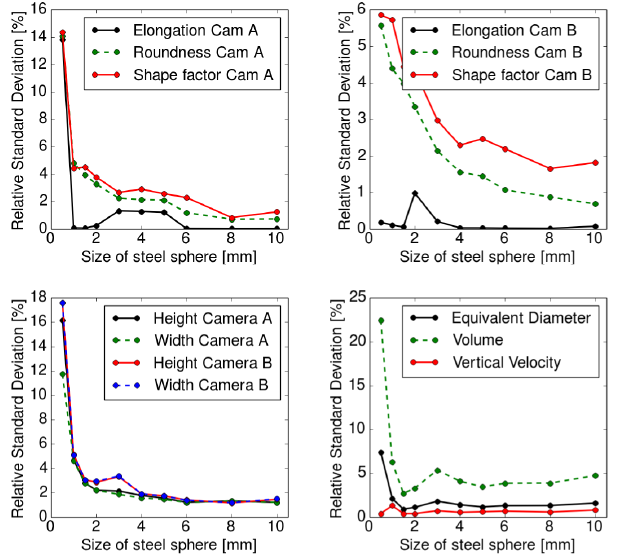
Figure 9. The relative standard deviation for the different quantities measured with steel spheres.